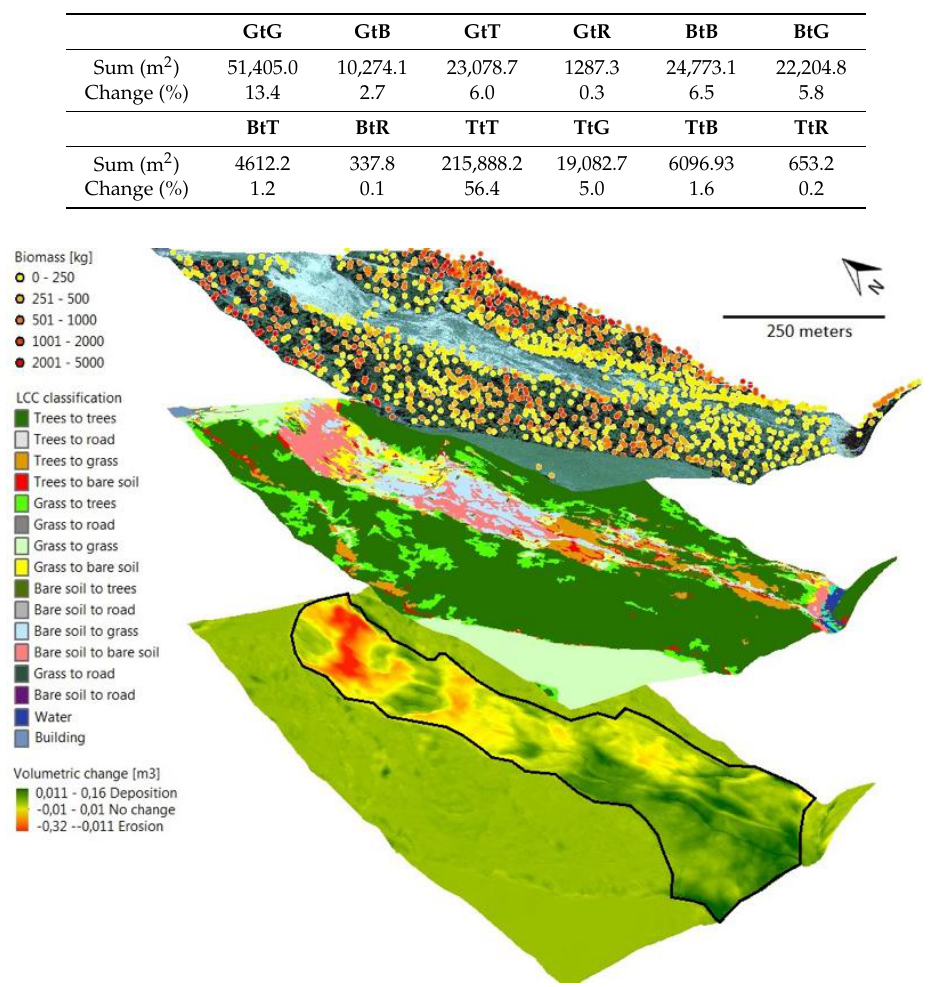
Figure 3. 3D-visualization of the change analysis. Upper panel: orthophoto and plot of AGB of individual tree tops. Middle panel: ‘from-to’ classification results of LCC. Lower panel: topographical volumetric change. Black line indicates the active landslide area.